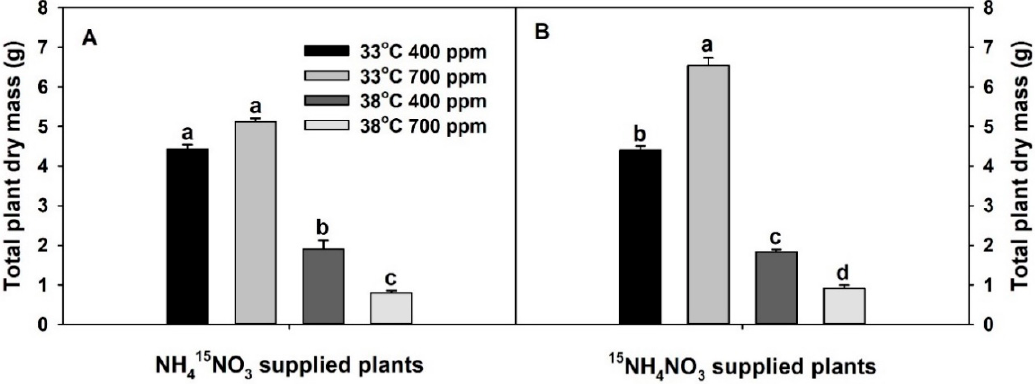
Figure 1. Effects of ambient (400 ppm) vs. elevated (700 ppm) CO 2 and near-optimal (33 °C) vs. chronic warming (38 °C) day-time temperatures on total plant dry mass (g) of Solanum lycopersicum labeled for 3 days with 1 mM ( A ) NH 415 NO 3 or ( B ) 15 NH 4 NO 3 and grown for 21 or 23 days, respectively. Each bar represents mean (n = 5) + 1 standard error of mean (SEM). Within each panel, bars not sharing the same letters are significantly different ( p < 0.05, Tukey’s test).